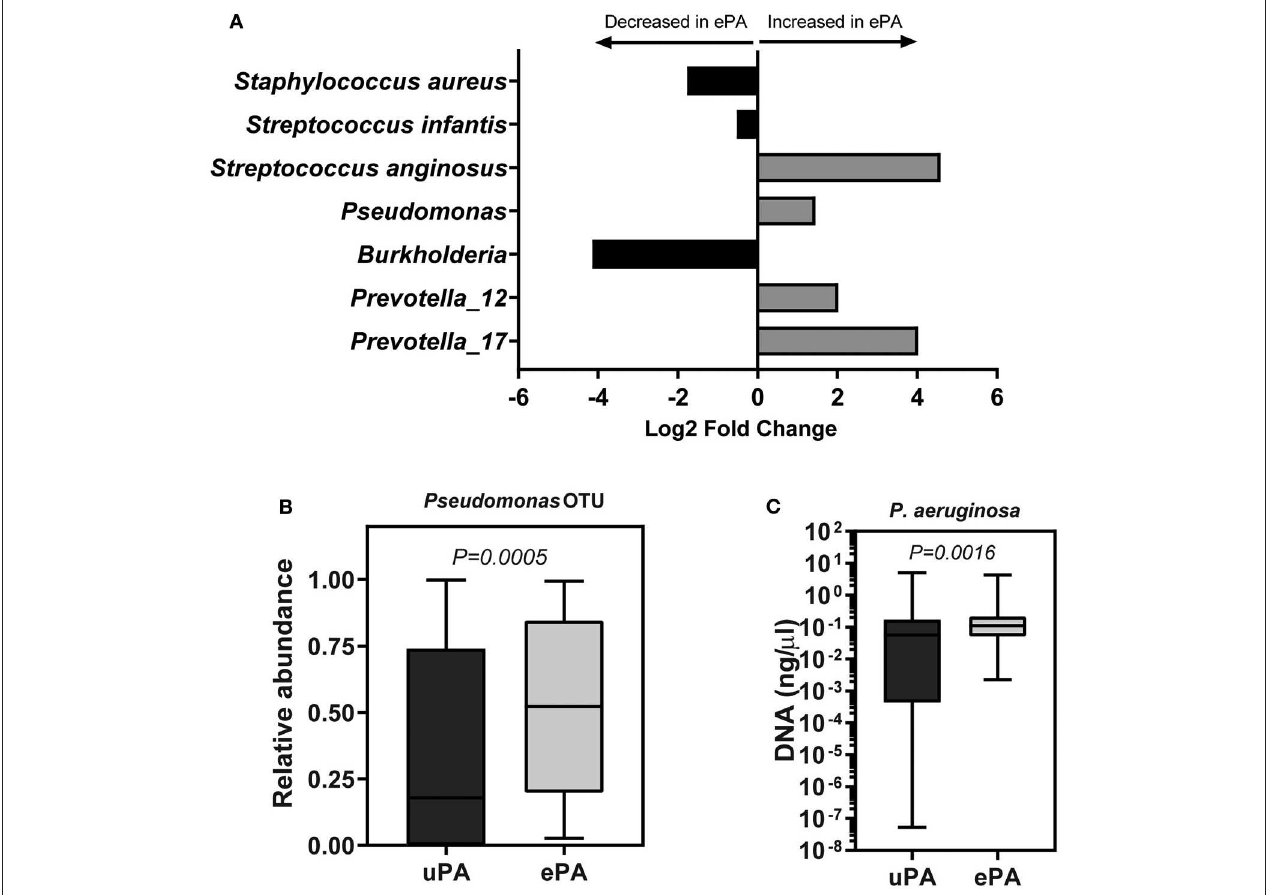
FIGURE 2 | OTUs that were significantly different between samples with epidemic and unique P. aeruginosa . Log 2 fold change of OTUs that were significantly abundant between ePA and uPA samples calculated by using DESeq2 ( P < 0.05, Wald test, and false discovery rate). Analysis was done using only the top 20 OTUs which accounted for > 0.2 % of total abundance for the whole data (A) . Relative abundance of Pseudomonas OTU reads between ePA and uPA samples, Wilcoxon rank-sum (Mann-Whitney) tests were performed (B) . qPCR of P. aeruginosa (uPA samples, 68; ePA, 71) in sputum samples of CF patients. Samples which their qPCR results were undetermined; they were not included in the illustration (graph is based on a logarithmic scale) or in the statistical analysis (Wilcoxon rank-sum (Mann-Whitney) test) (C) . For (B,C) graphs, the median and interquartile ranges (IQR) are indicated as the middle, top and bottom lines of each box. Ends of the whiskers mark the min and max. ePA, epidemic strains of P. aeruginosa ; uPA, unique strains of P. aeruginosa; OTU, operational taxonomic